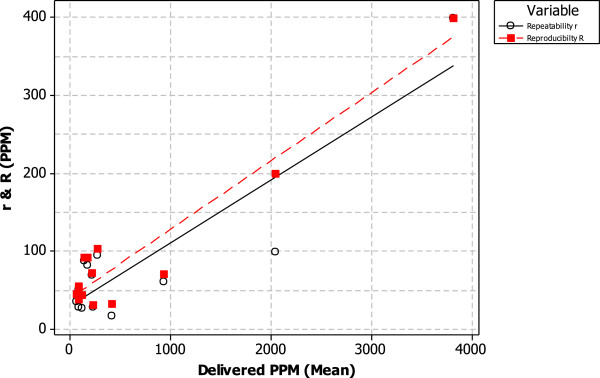
Scatterplot of repeatability (r) (white circle) and reproducibility (R) (red square).